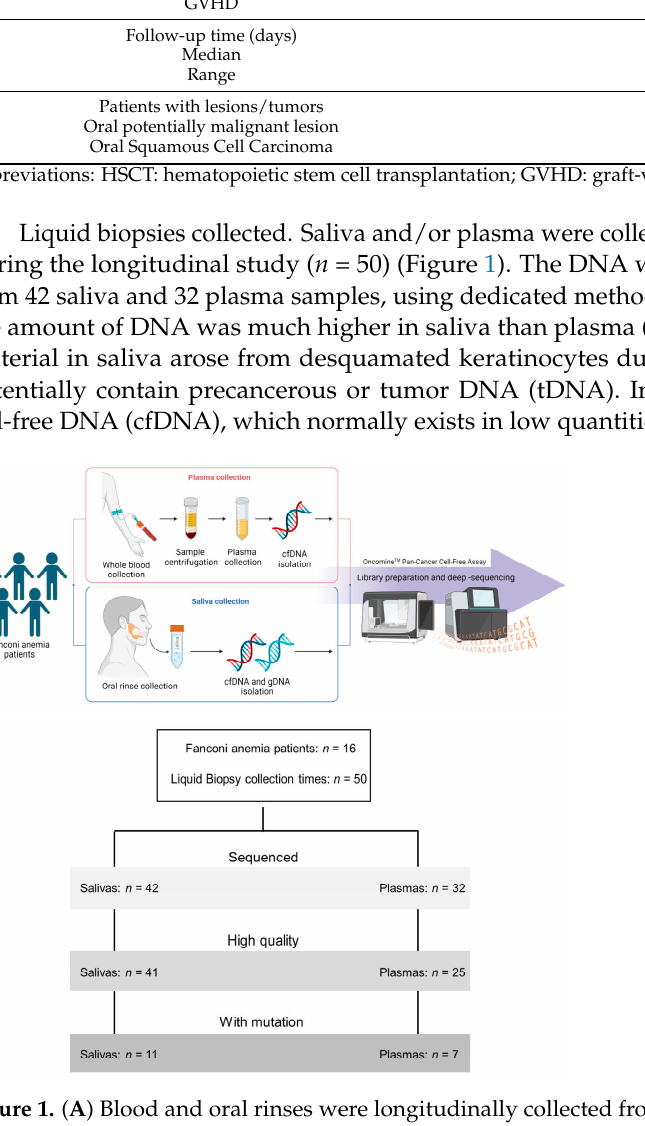
Figure 1. ( A ) Blood and oral rinses were longitudinally collected from FA patients with no clinical diagnoses of OPML and/or OSCC. DNA was purified and deep-sequenced using the Oncomine TM Pan-Cancer Cell-Free Assay (OPA) from Thermofisher. Bioinformatics analysis was performed to detect the presence of mutations in cancer genes in the liquid biopsies. ( B ) There was a total of 50 collection times of liquid biopsies from 16 FA patients during the clinical study. A subset of samples was deep-sequenced with the OPA assay. Only high-quality sequencing runs were analyzed for the presence of cancer mutations.